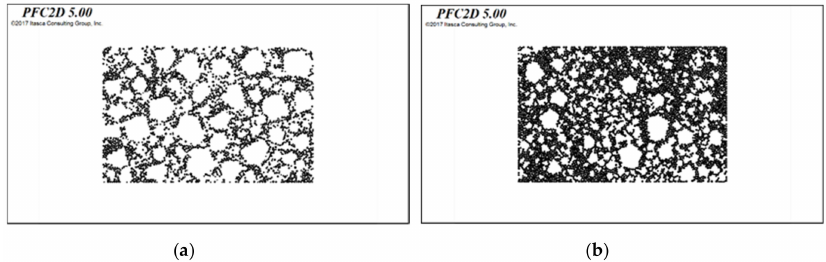
Figure 5. Distribution of fine aggregate in the ( a ) OGFC and ( b ) AC PFC model.